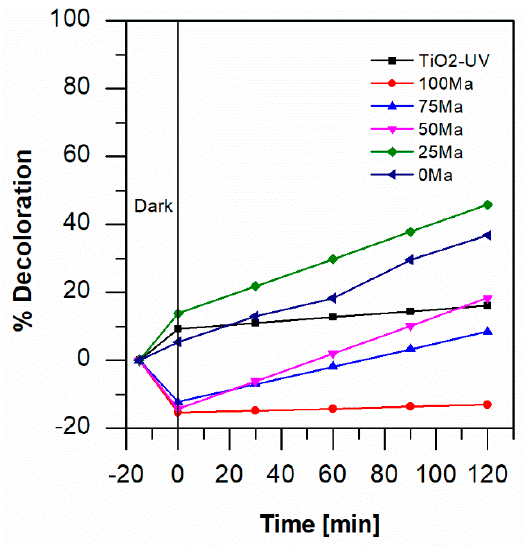
Figure 3. Percentage of degradation by photocatalysis of 1 mM of aniline blue at pH 7 with TiO 2 -foam/UV light and with TiO 2 -anthocyanin-foam/visible light.